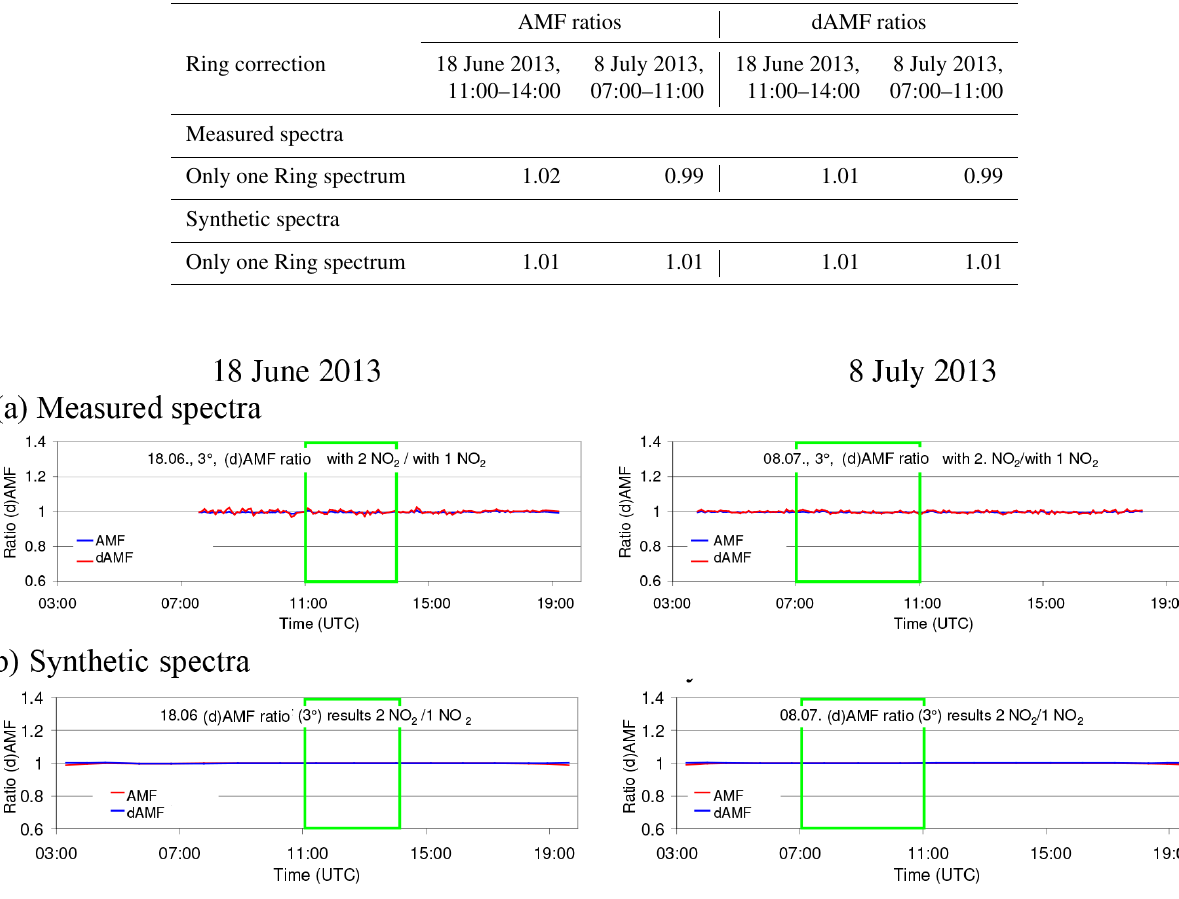
Figure A19. Ratios of the O 4 (d)AMFs derived for the analysis with a second NO 2 cross section (for 220K) vs. those for the standard analysis (only NO 2 cross section for 294K) for both selected days ( a : results for spectra measured by the MPIC instrument; b : results for synthetic spectra when taking into account the temperature dependence of the O 4 cross section).